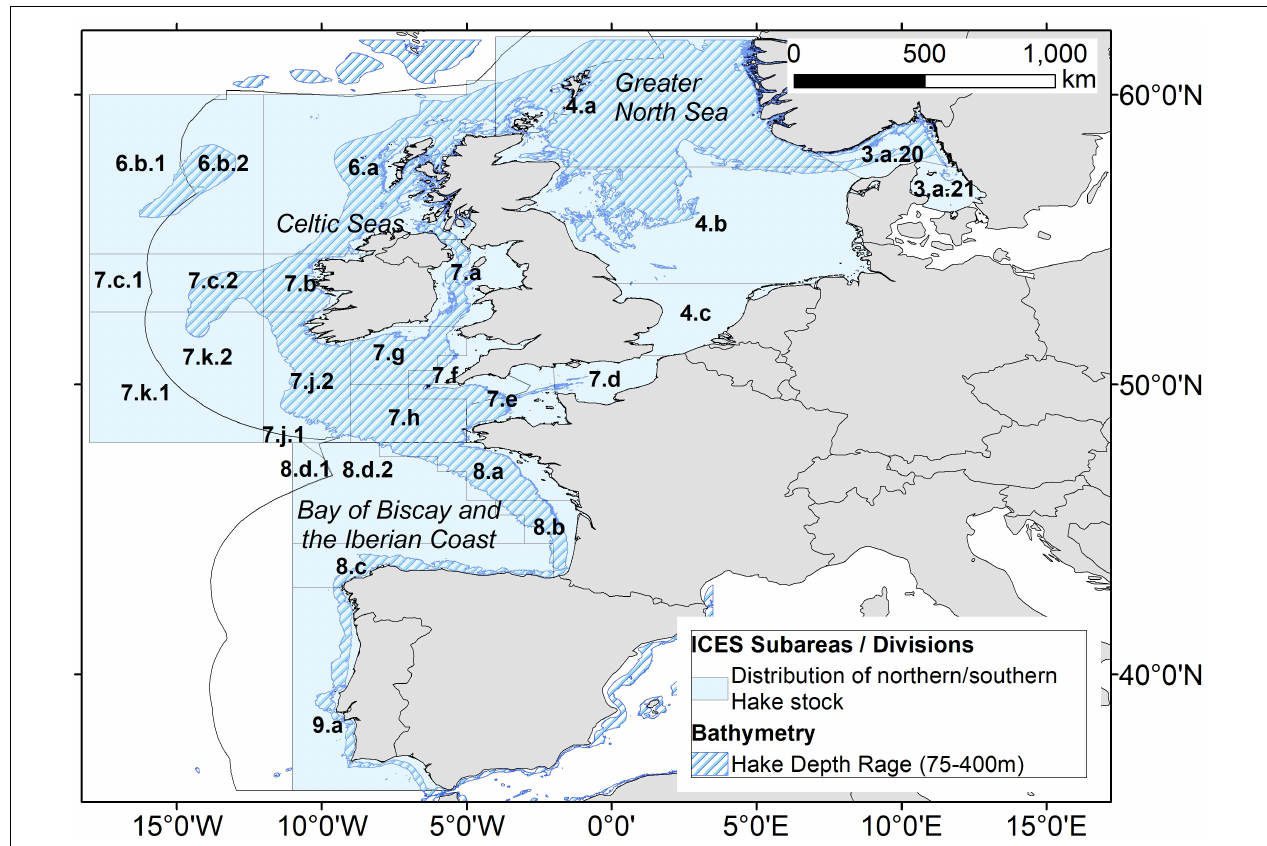
FIGURE 1 | Map showing the combined ICES Subareas and Divisions where the northern and southern hake stocks are distributed. Shaded areas indicate the approximate depth preference for hake species, 75–400 m [Bathymetry data downloaded from EMODnet Bathymetry Consortium